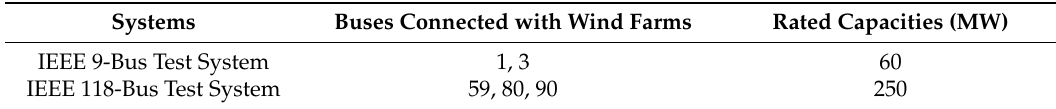
Table 1. The rated capacities of wind farms and corresponding buses.